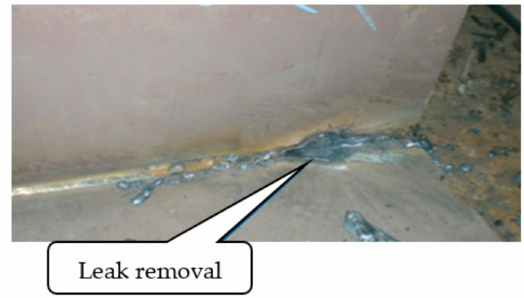
Figure 18. Piece leak